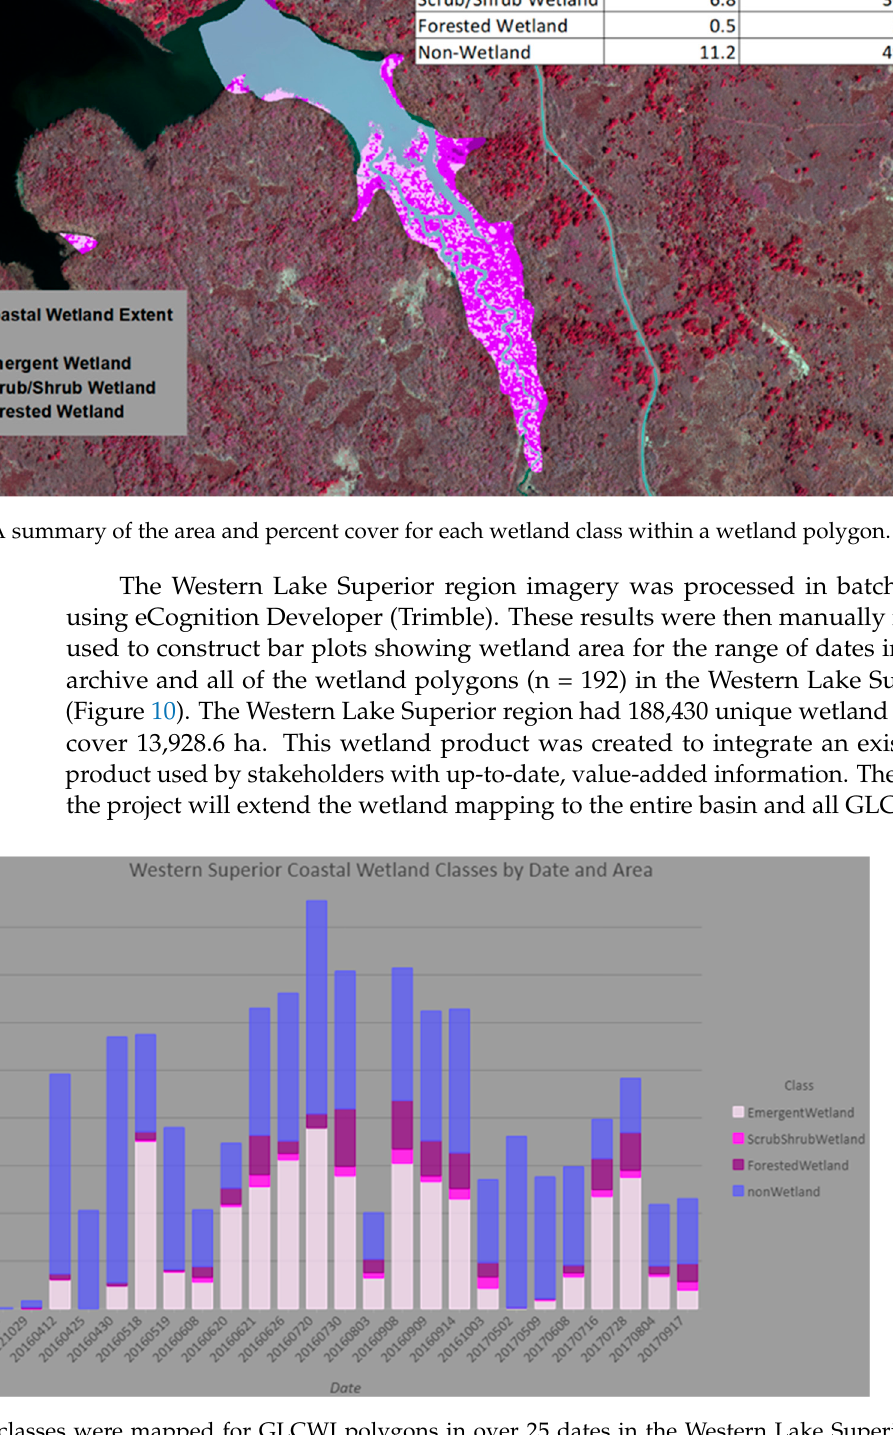
Figure 10. Wetland classes were mapped for GLCWI polygons in over 25 dates in the Western Lake Superior region. Emergent wetlands increased at the beginning of the growing season and decreased by the end of the season for the 2016 and 2017 datasets.